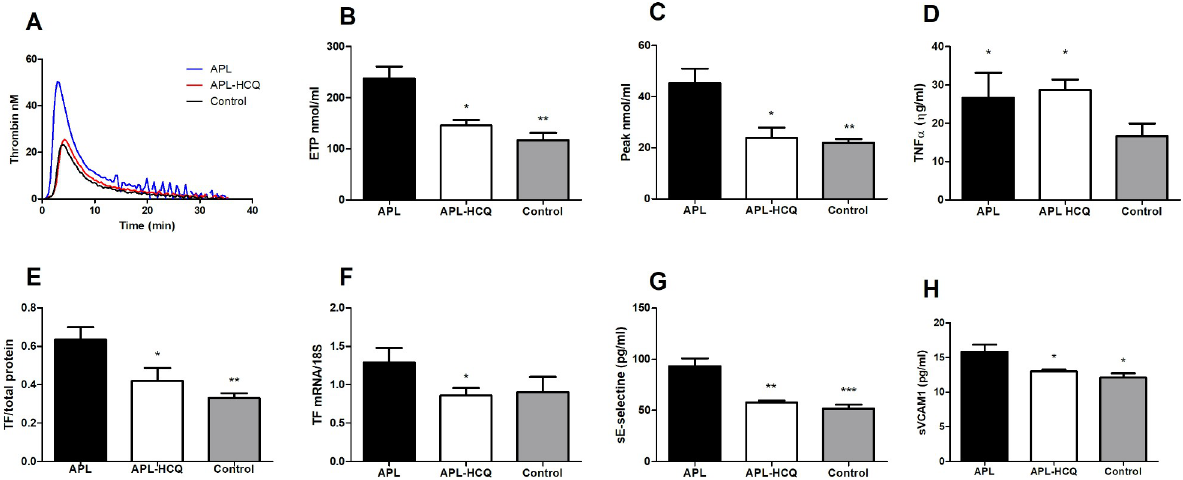
Fig 2. Effects of aPL and HCQ on procoagulant and inflammatory properties in mice. (A) Thrombin generation curves, (B)endogenous thrombin potential, (C) peak thrombin measured by calibrated automated thrombography (CAT) in the presence of Activated C protein (APC).(D) Plasma levels of TNF α , (E) carotid Tissue Factor expression assessed by western blotting and (F) aortic TF mRNA expression assessed by RT-PCR. (G) Plasma levels of sE-selectin, and (H) sVCAM-1 assessed by ELISA. Values are mean ± SEM � : P < 0 . 05 ; �� : P < 0 . 01 ��� : P < 0 . 001; n = 5 / group.